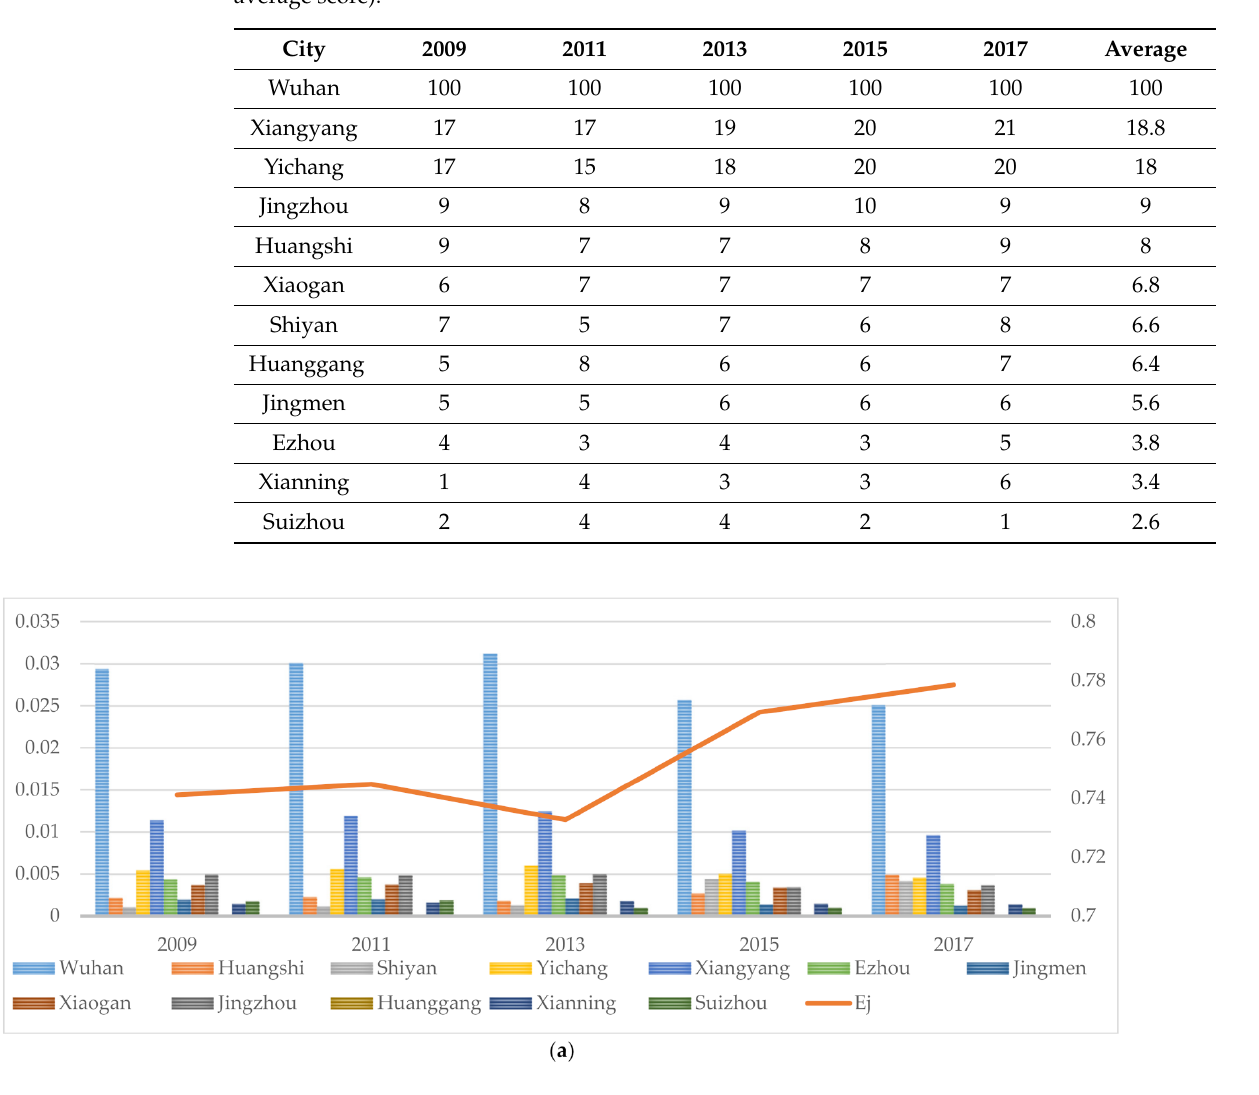
Table 5. The urban competitiveness score in Hubei province (in descending order according to the average score).